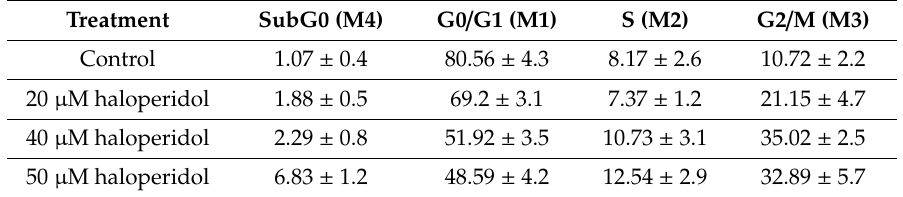
Figure 2. Cell-cycle distribution assessed by flow cytometry in U87 glioblastoma cells. Approximately 10,000 cells were seeded in 24-well plates and after 24 h were exposed to escalating concentrations of haloperidol for another 72 h. At 72 h, the cells were stained by propidium iodide and the DNA content was evaluated. Table 1. Cell-cycle distribution assessed by flow cytometry in U87 glioblastoma cells. Haloperidol induced G2 / M cell cycle